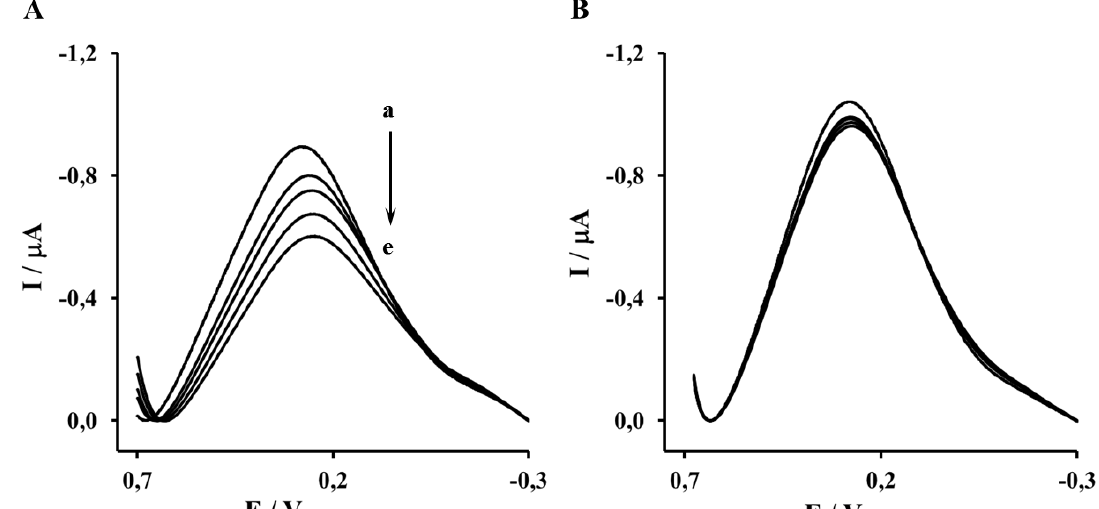
Figure 7. The OSWV responses of: ( A) Au-NAC/DPTA–Cu(II)–His domain, ( B ) Au-NAC/DPTA–Cu(II)–His the presence of 50 mM TRIS hydrochloride, 300 mM NaCl, pH 7.4: (a) 0.000, (b) 0.001,